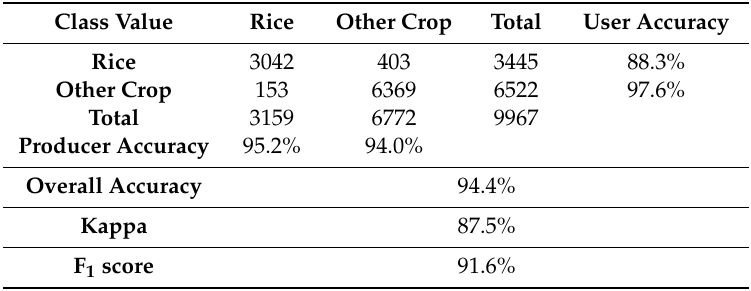
Table 4. Confusion matrix for the comparison between rice areas derived from Ndikumana Agricultural Land Cover and rice areas from RPG-2017